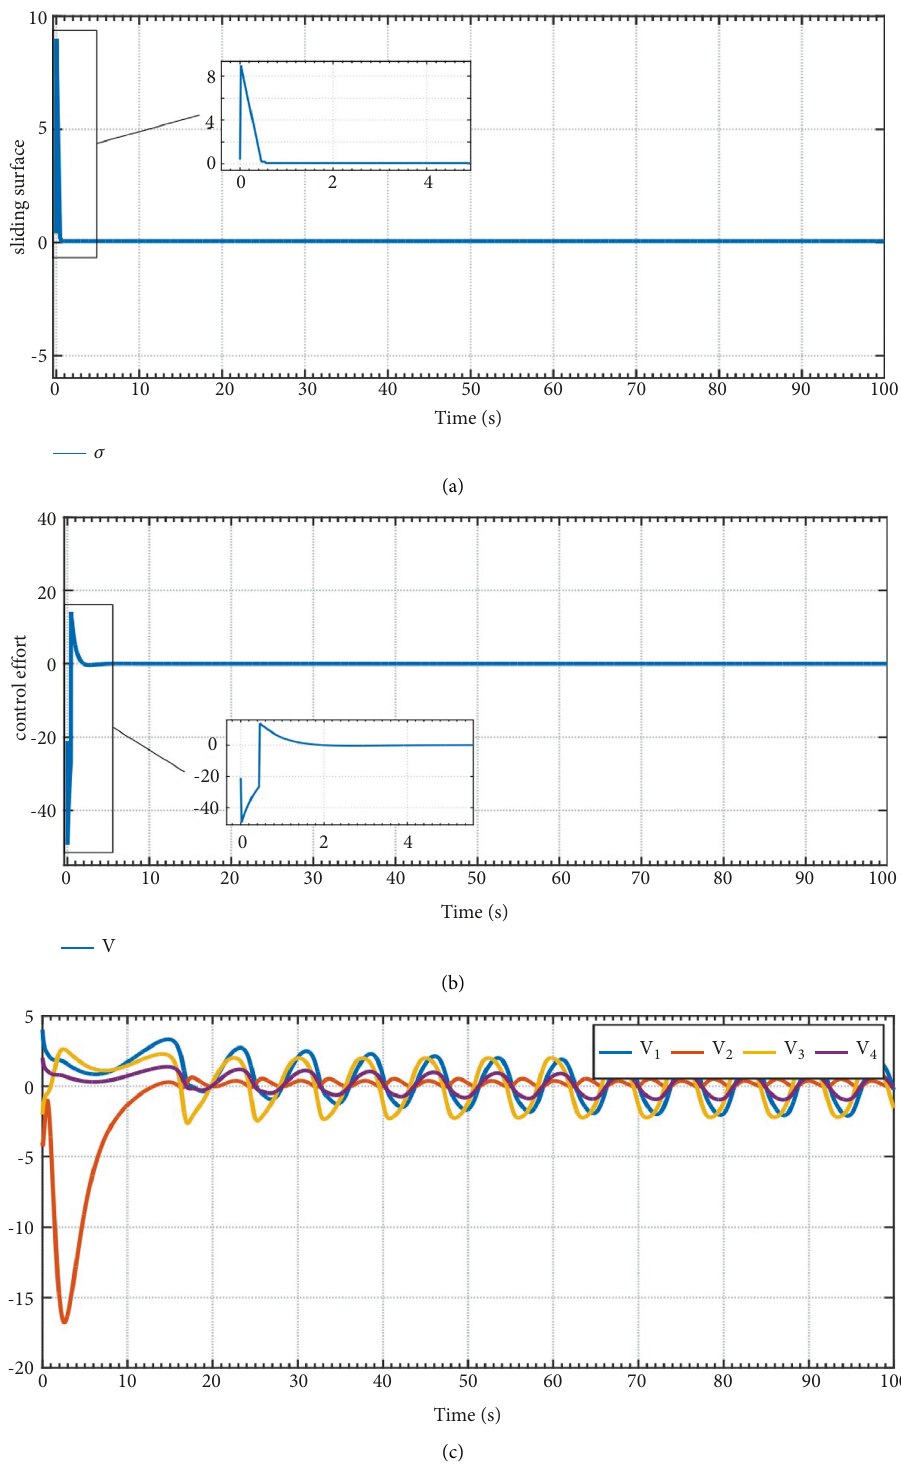
Figure 2: Synchronization of identical 4D hyperchaotic financial system. (a) Sliding manifold σ . (b) Control effort v . (c) v represent the time-varying